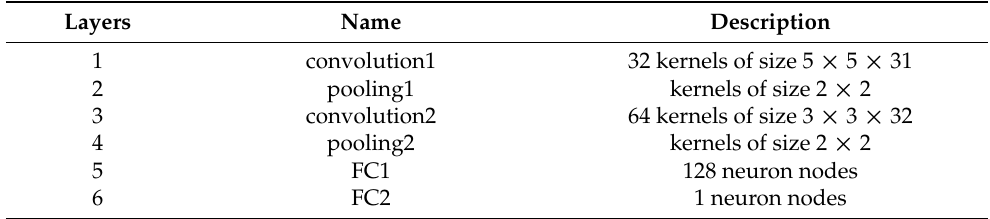
Table 3. Parameter configuration of the discriminator of GAGAN.